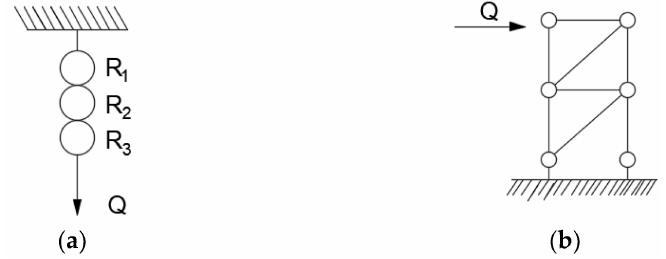
Figure 1. Two simple series systems. ( a ) Series members, ( b ) Truss